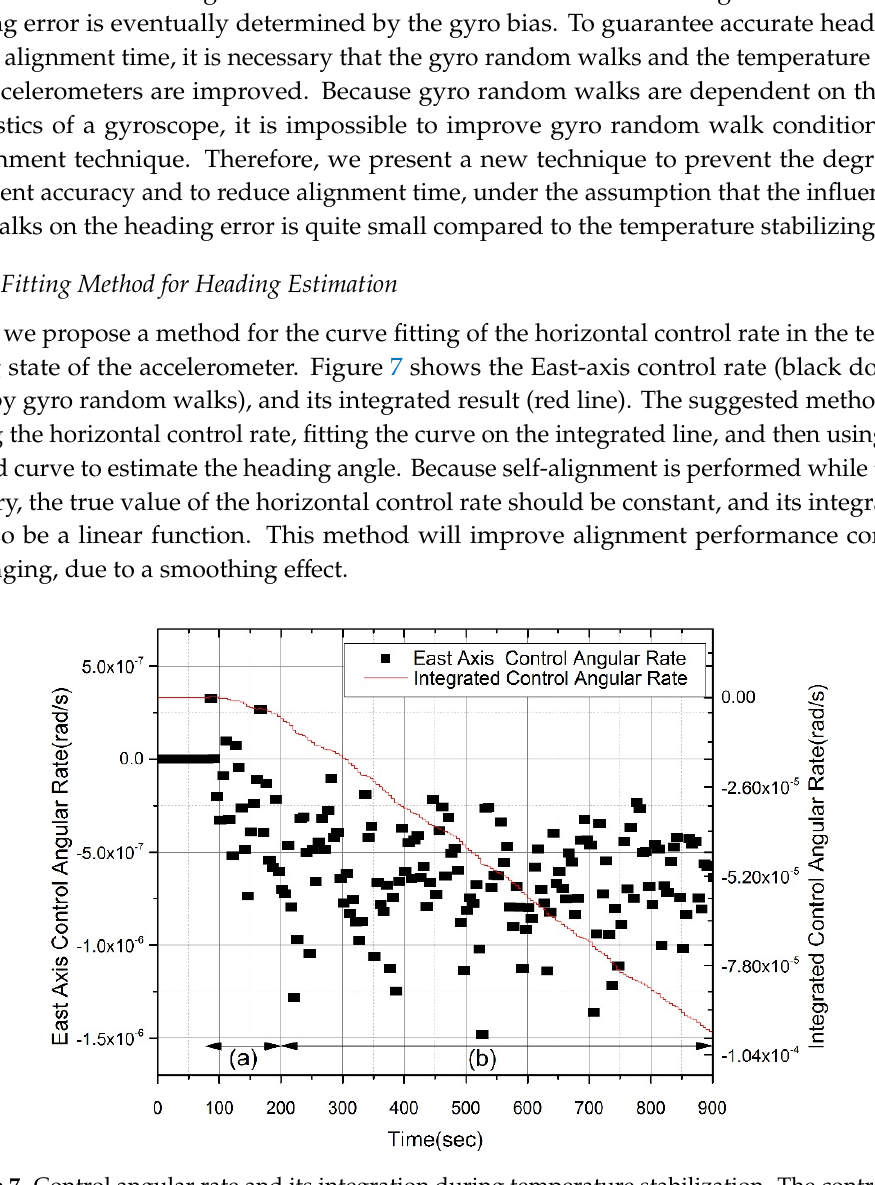
Figure 7. Control angular rate and its integration during temperature stabilization. The control rate changes exponentially in (a) region because of the temperature stabilizing error. The control rate is stabilized in (b) region and its integrated curve is almost linear. The control rate is overall scattered by gyro random walks, and its integrated curve has a minor deviation in both (a) and (b) region. Equation (27) is the integrated result of the horizontal control rate, ˆ ω c . This equation includes four terms. The first is a linearly increasing term that includes the true value of ˆ ω c and the gyro bias. The second term is a constant. The third is a decay term generated by the temperature stabilization of the accelerometers. The fourth term is generated by a gyro random walk. Applying Taylor series expansion to the exponential function, Equation (27) can be expressed as Equation (28). After total-averaging using Equation (23), the control rate is expressed as Equation (29). The conventional method uses Equation (29) to obtain the horizontal control rate. Therefore, heading accuracy could be degraded and the alignment time could be made longer by the temperature stabilizing error, which is the second term of Equation (29).